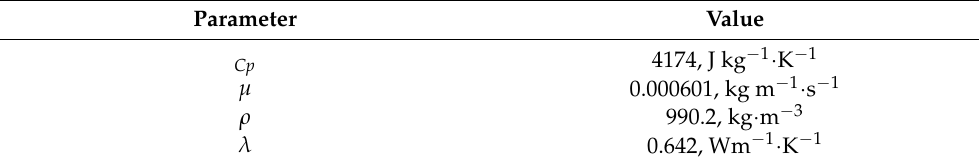
Table 5. Physical properties parameter of water.